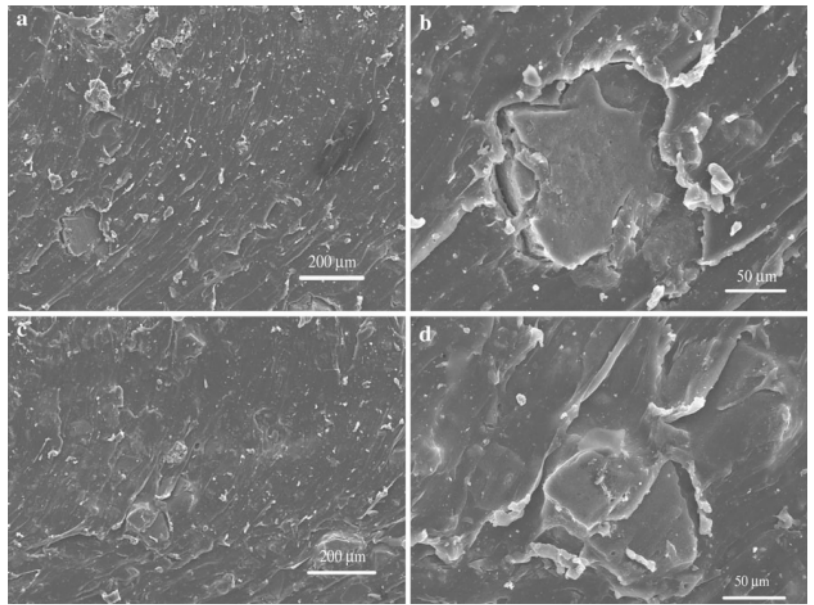
Figure 30. SEM micrographs of the tensile fracture surfaces of SBR compounds filled with GTR ( a , b ) or RTR ( c , d ) (30 phr) (reproduced with permission from [126]).